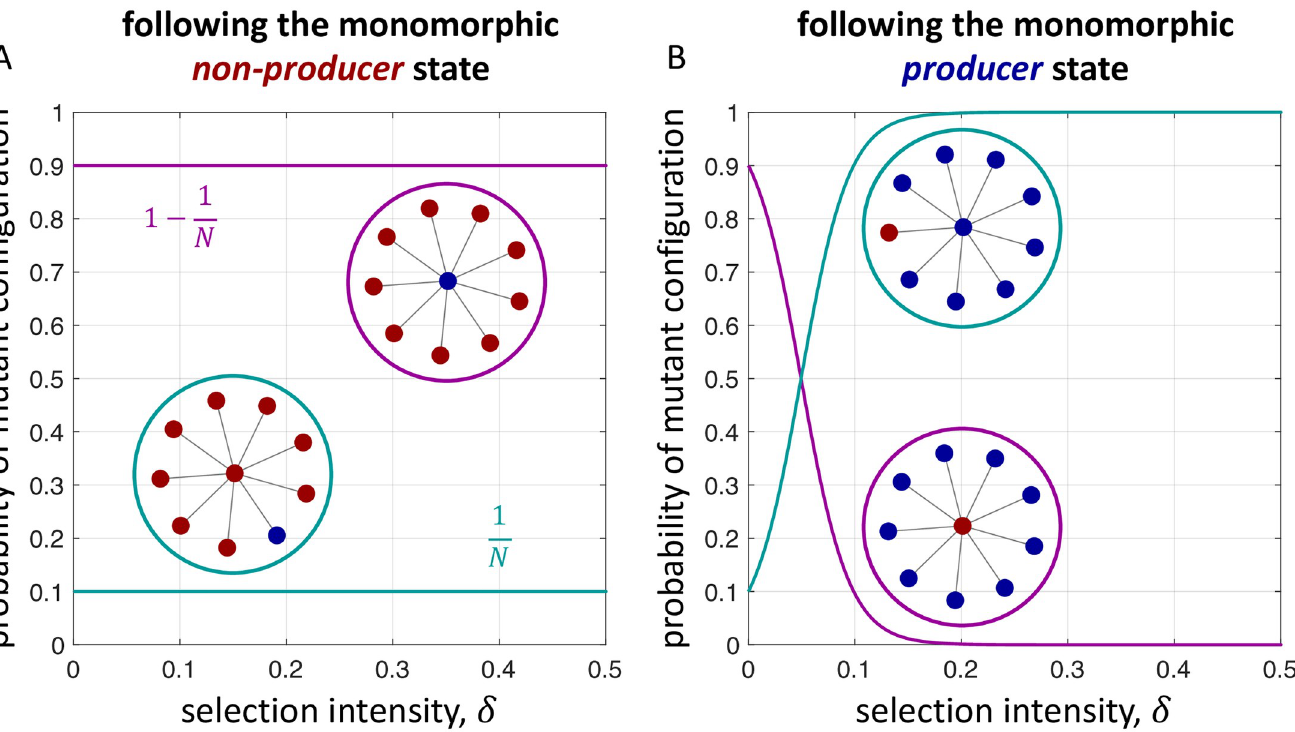
Fig 2. Temperature-based mutant initialization for ff -goods under Birth-death updating. A, Following the monomorphic non-producer state, a mutant producer appears either in the hub (purple) or a leaf (turquoise). Since everyone has the same payoff (zero) in the all-non-producer state, the death rates are the same as those of neutral drift, for all δ ⩾ 0. With probability 1/ N , the hub gives birth and the mutant offspring is propagated to a leaf node. Otherwise, with probability 1 − 1/ N , a leaf node gives birth and the mutant arises in the hub. B, In contrast, death rates in the monomorphic producer state depend on selection intensity. Outside of weak selection, the hub is overwhelmingly more likely to reproduce than a leaf node, meaning a mutant appears in a leaf (turquoise). Although a non-producer at the hub, surrounded by producers, would have a high payoff and thus a high probability of spreading its behavior throughout the population, this mutant configuration appears with probability rapidly approaching zero as δ grows (purple). Parameters: N = 10, b = 5, and c = 1.